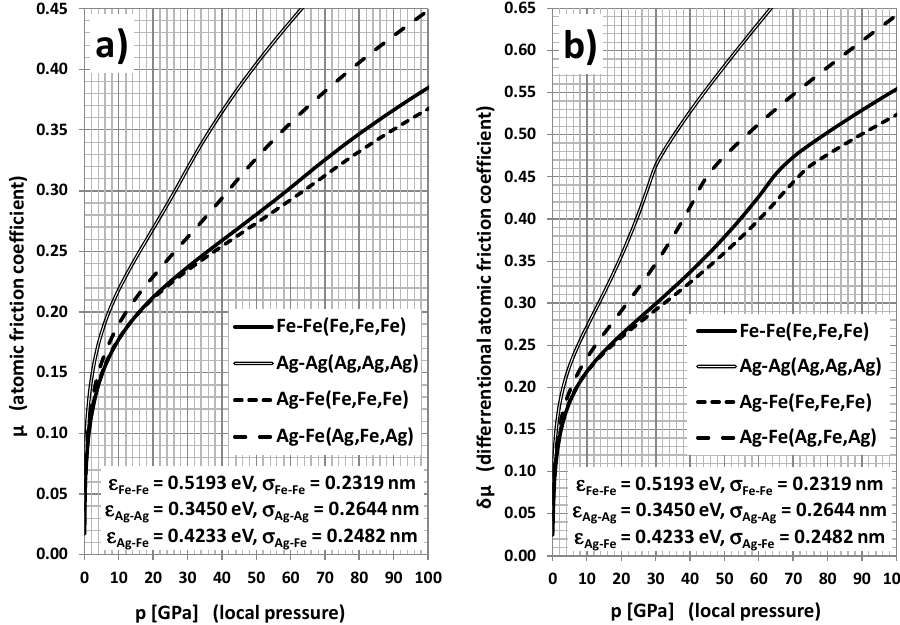
Figure 5. Regular ( a ) and differential ( b ) atomic friction coefficient dependence on local pressure for different atomic pairs: Fe-Fe(Fe,Fe,Fe), Ag-Ag(Ag,Ag,Ag), Ag-Fe(Fe,Fe,Fe), and Ag-Fe(Ag,Fe,Ag). Atoms specified in parentheses constitute a rigid environment of “elastic” atom of base.